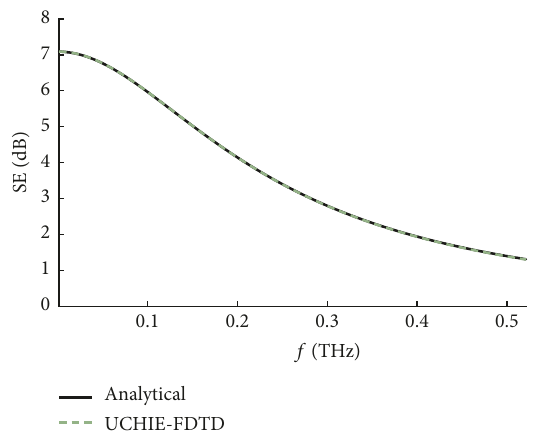
Figure 6: Fields recorded in the observation point behind the graphene sheet. Only a small part of the total simulated time ( 0.6428 ns) is shown.